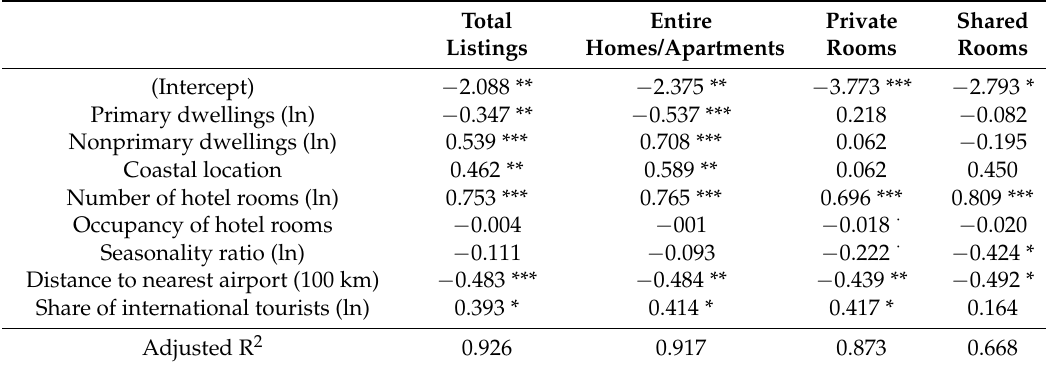
Table A8. Initial linear models for tourist areas/sites (N =